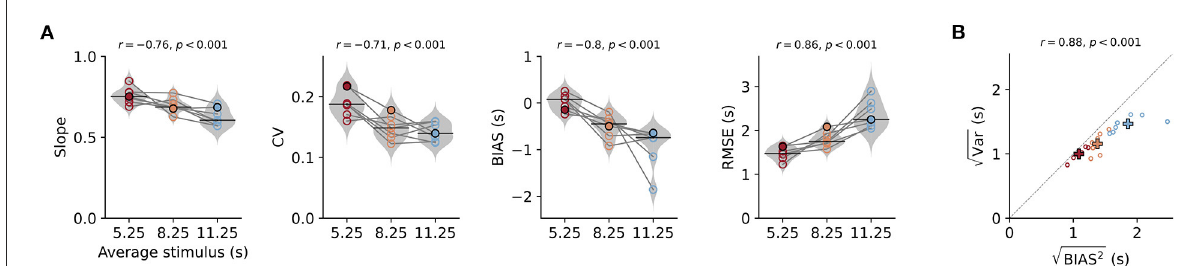
FIGURE2 Behavioral characteristics of time reproduction. (A) The slope of the linear regression between stimuli and reproductions – quantifying the strength of the regression effect, with values closer to 1 meaning less regression—coefficient of variation (CV), average bias, and RMSE for each animal across stimulus ranges. Values from single animals are displayed as open circles connected by lines. Gray violin plots illustrate distributions over all animals, and black solid lines mark the medians. The color indicates (s)mall, (i)ntermediate, and (l)ong stimulus ranges. The filled markers belong to the data of the animal in Figures 1D–F. Above the panels, the Pearson correlation coefficients of the parameter with the average stimulus duration and corresponding p -values are given. (B) Correlation between the square roots of the average variance and the average squared bias for the three stimulus ranges across all animals. The distance from the origin of the coordinate system is the RMSE. Crosses mark averages over animals for each range. Color code as in (A) . Both values increase with range and are strongly correlated.